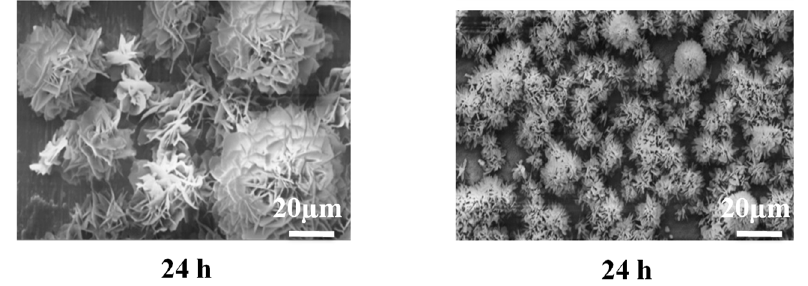
Figure 7. SEM images of the Polished ‐ Ti and Ti ‐ AT after immersion in the calcium phosphate solution at 60 °C (Ti ‐ IT60° and Ti ‐ AT ‐ IT60°). There was no HA precipitation observed on the Ti ‐ IT60° after immersion in the solution for 30 min. HA spherical particles were found on the Ti ‐ IT60° after immersion for 6 h and they grew into large spherical particles after immersion for 24 h. On the Ti ‐ AT ‐ IT60°, small HA spherical particles precipitated after immersion for 30min. The spherical particles grew larger with time and covered the entire surface of a titanium after immersion for 24 h.